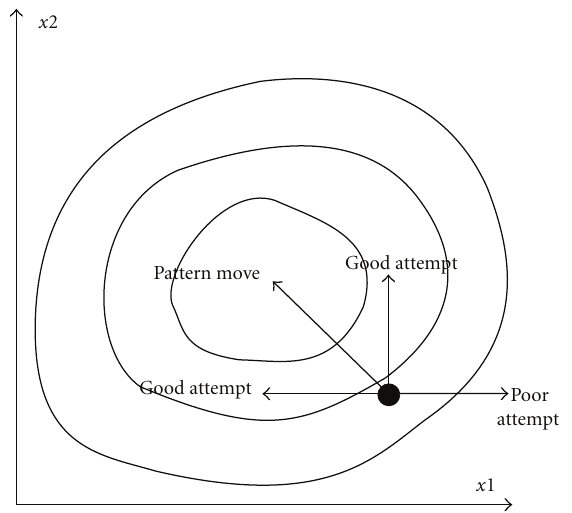
Figure 3: Pattern search diagram.